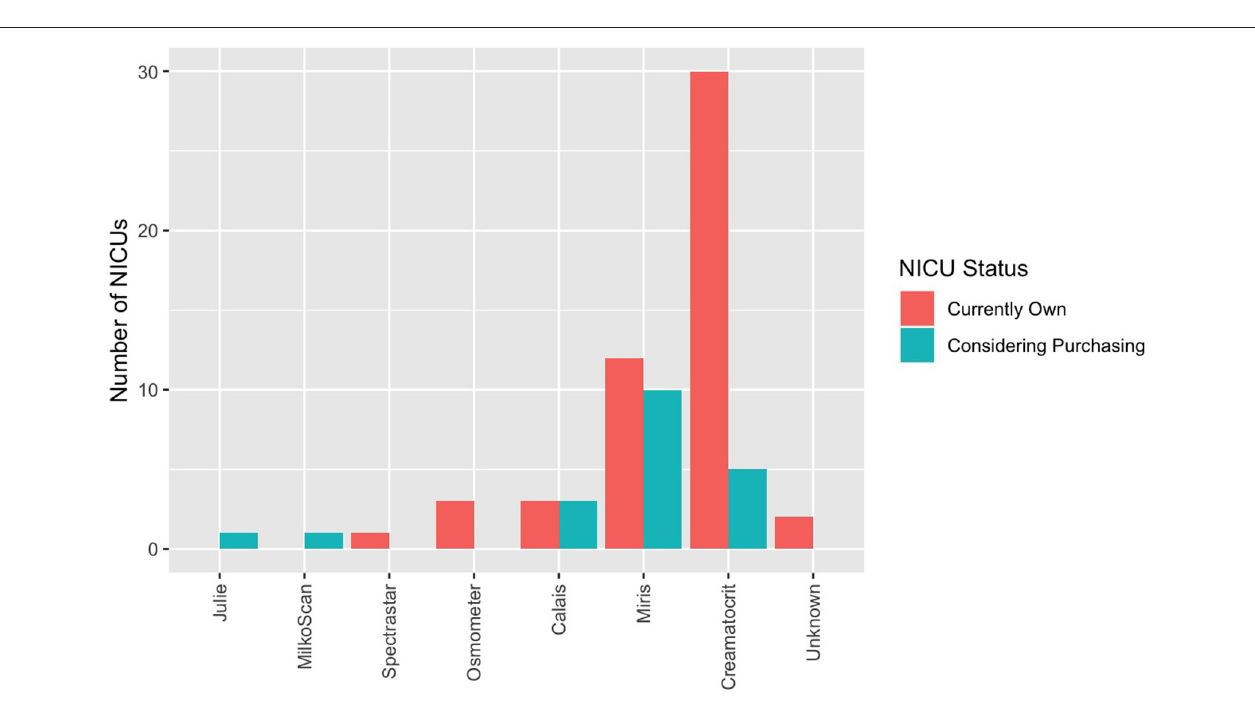
FIGURE 4 | Human milk analyzers in NICUs. What unit currently own (for research or clinical use) and what they are considering